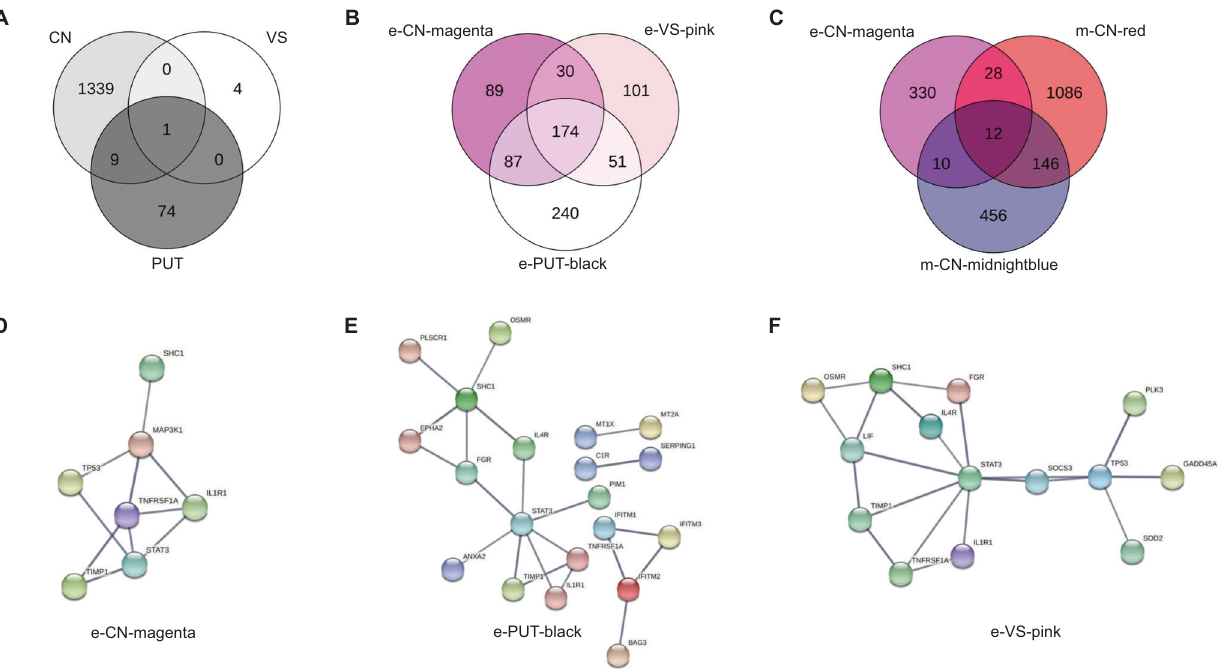
Fig. 2 Venn Diagrams of Gene Overlap and Network Plots of WGCNA Module Hub Genes. Venn Diagrams of gene overlap of A DE genes at FDR < 0.25 in caudate nucleus (CN), putamen (PUT), and ventral striatum (VS), B genes forming WGCNA expression-modules showing the strongest association with AUD status for CN, PUT, and VS, C genes forming WGCNA expression-module “ e-CN-magenta ” and those forming the methylation-modules “ m-CN-red ” and “ m-CN-midnightblue ” . Network plots depicting the WGCNA gene expression module hub genes showing the strongest association with AUD: D module magenta from caudate nucleus, E module black from putamen, and F module pink from ventral